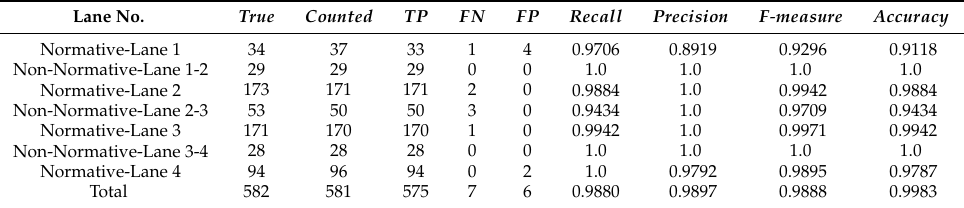
Table 9. The counting results of Mofan